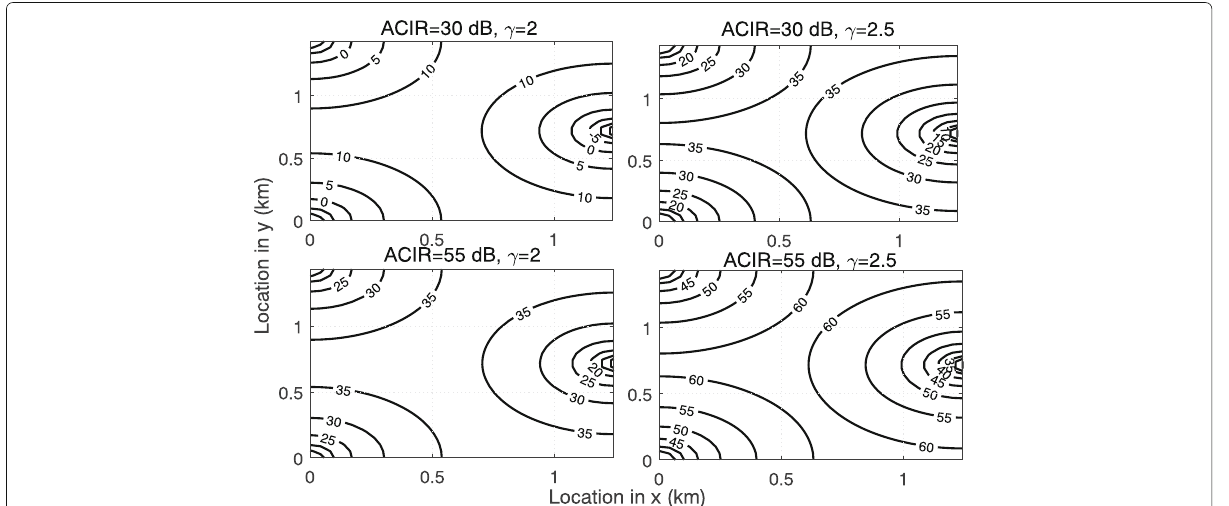
Fig. 10 Maximal FD transmission power vs location in the presence of 3 PUCCH-receiving BSs